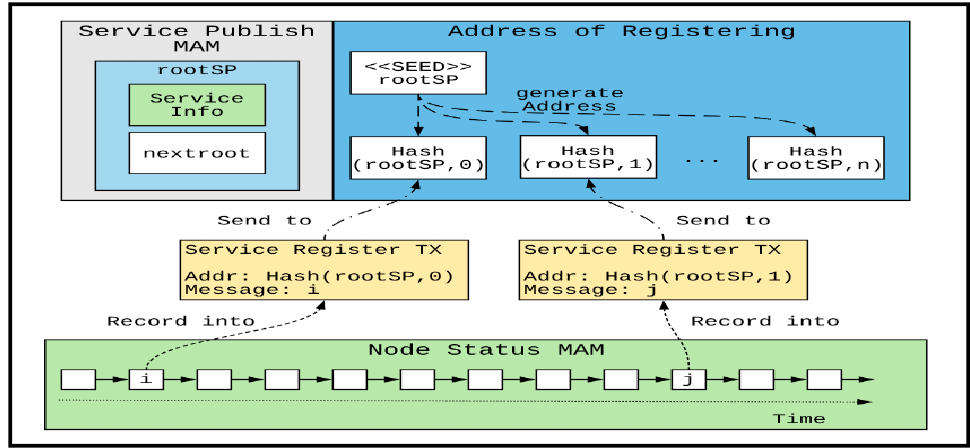
Figure 6. Time-difference registration addressing .